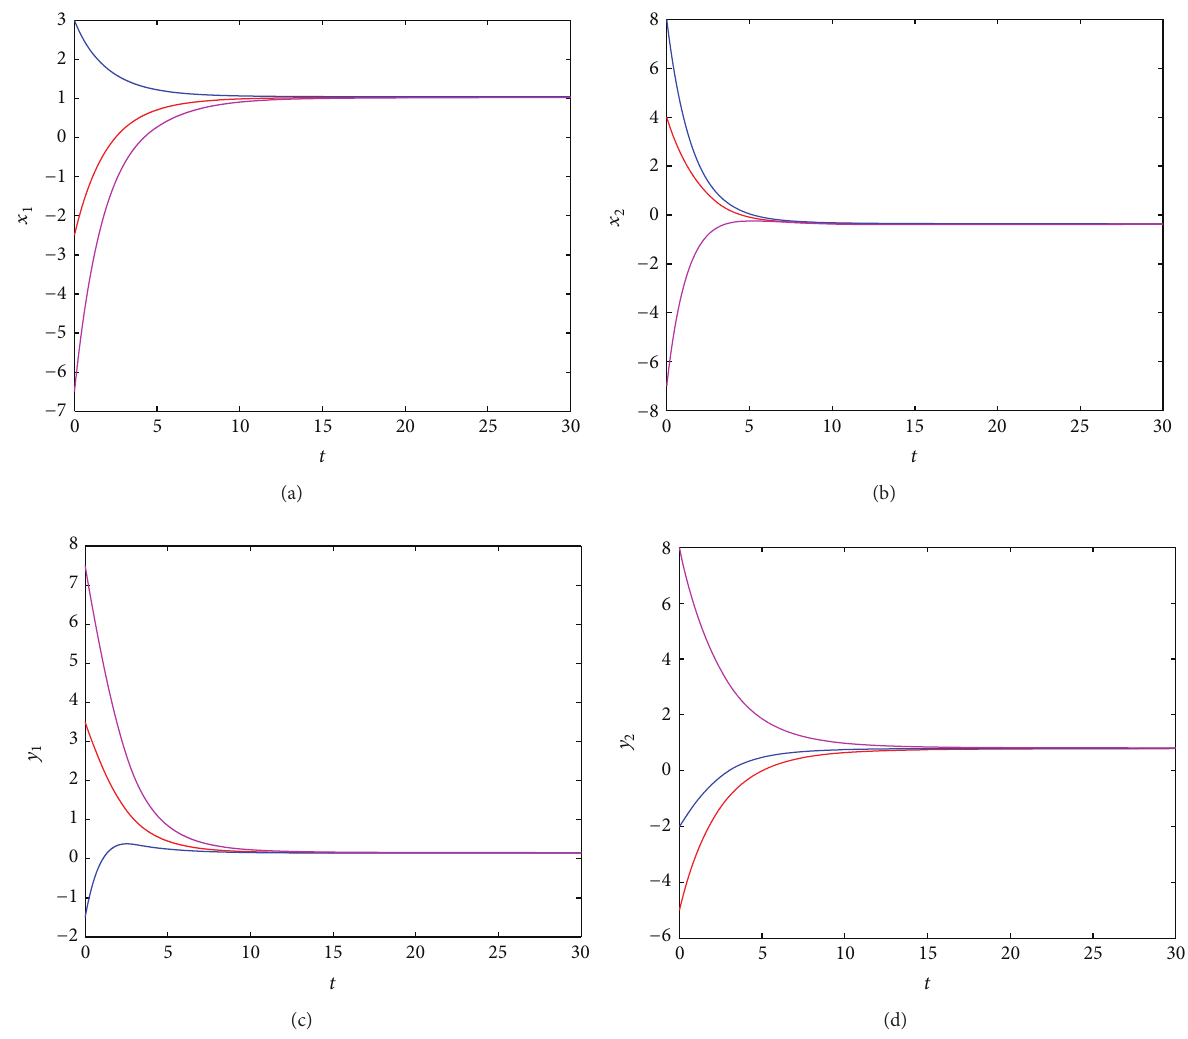
Figure 4: Transient states of the fractional-order BAM neural networks in Example 2 with 𝛼 = 0.98 , 𝜎 = 0 , and 𝜏 = 0.40